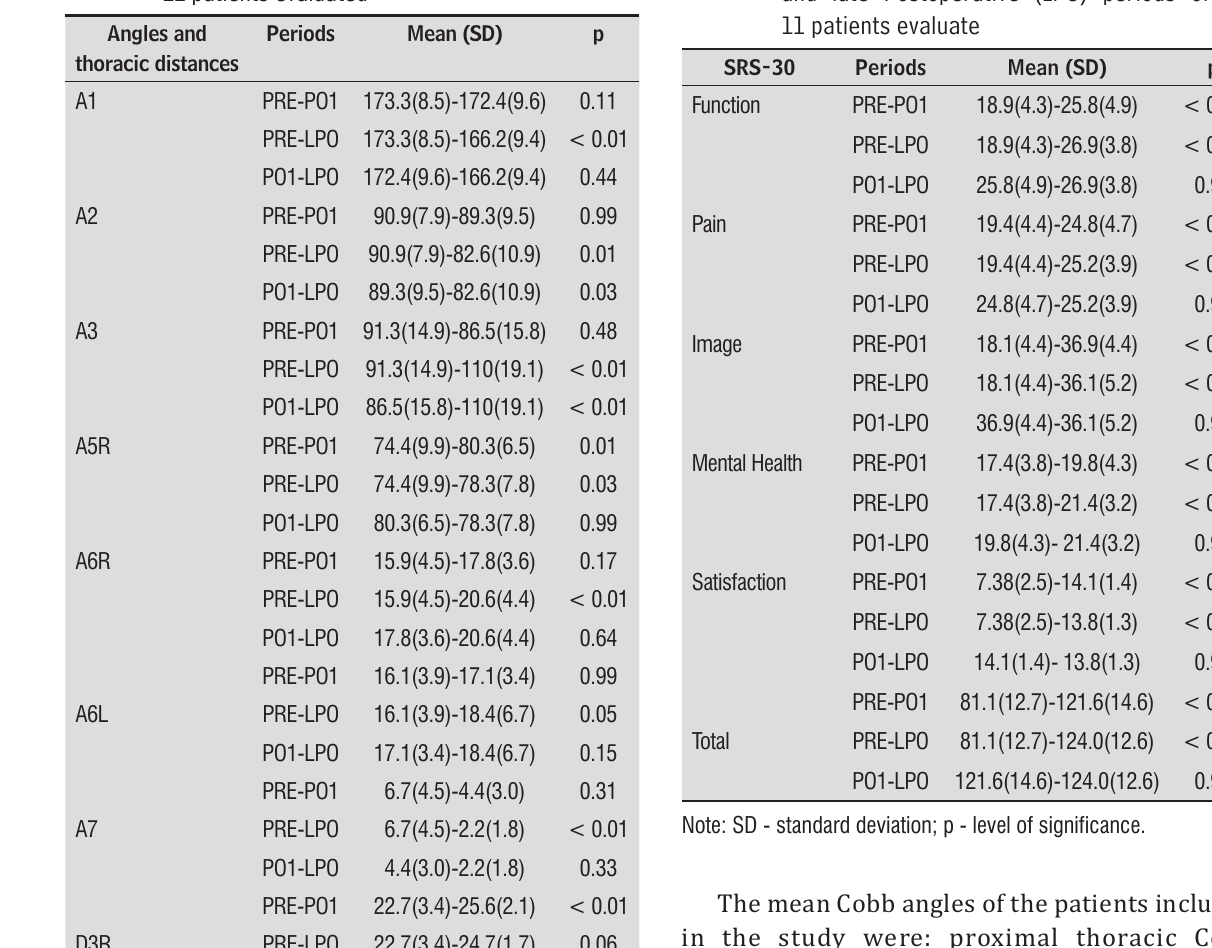
The mean Cobb angles of the patients included